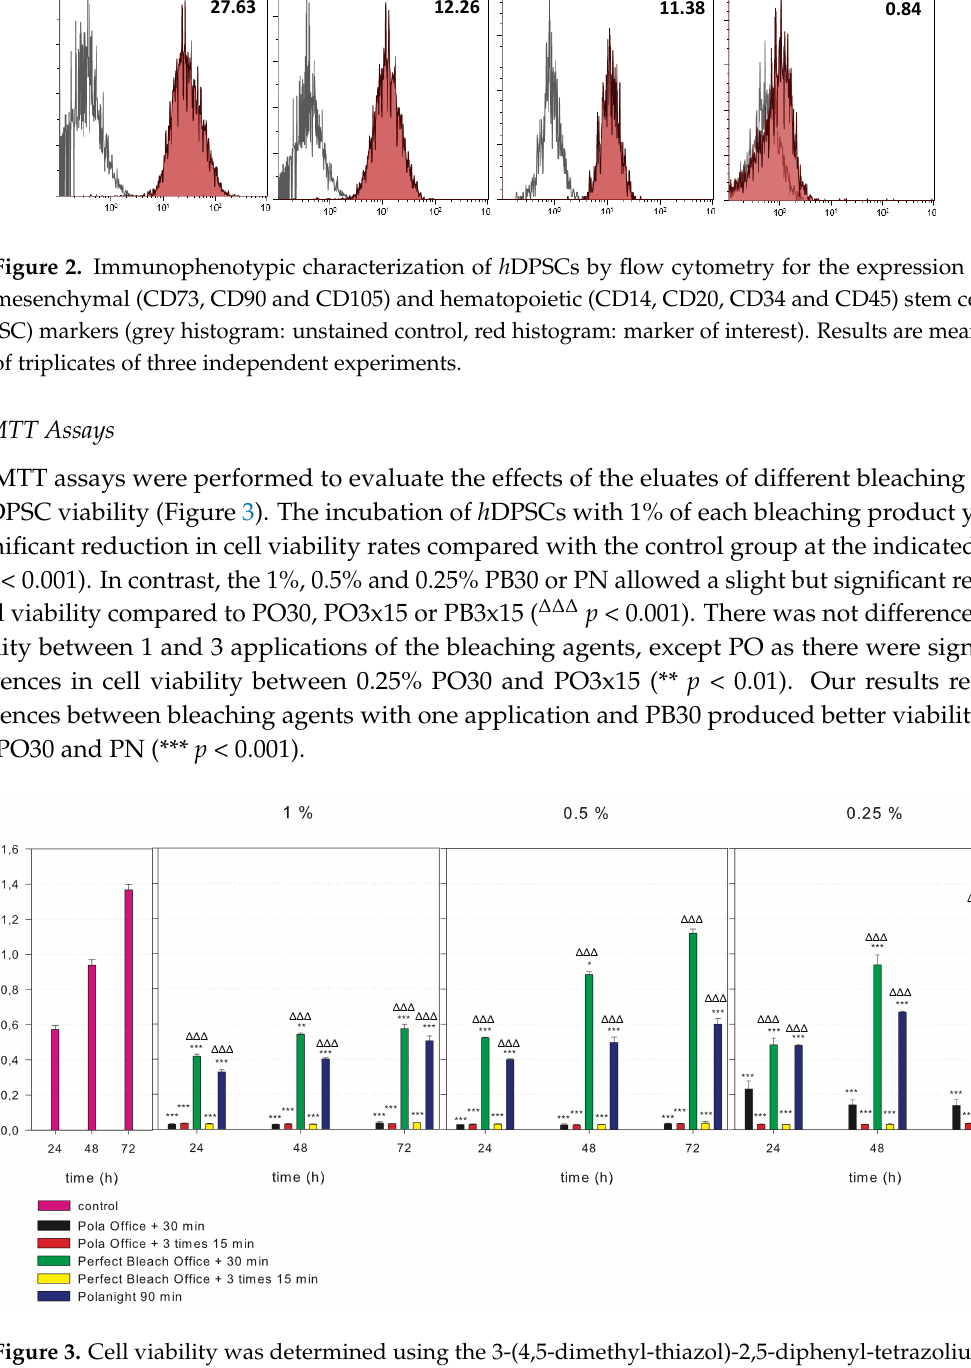
Figure 3. Cell viability was determined using the 3-(4,5-dimethyl-thiazol)-2,5-diphenyl-tetrazolium bromide (MTT) assay. The incubation of hDPSCs with 1% of each bleaching product revealed a significant reduction in cell viability rates compared with those in the control group at the indicated times of culture (*** p < 0.001). In contrast, a slight but significant recovery of cell viability was observed with 1%, 0.5% and 0.25% PB30 or PN compared to the others ( ∆∆∆ p <